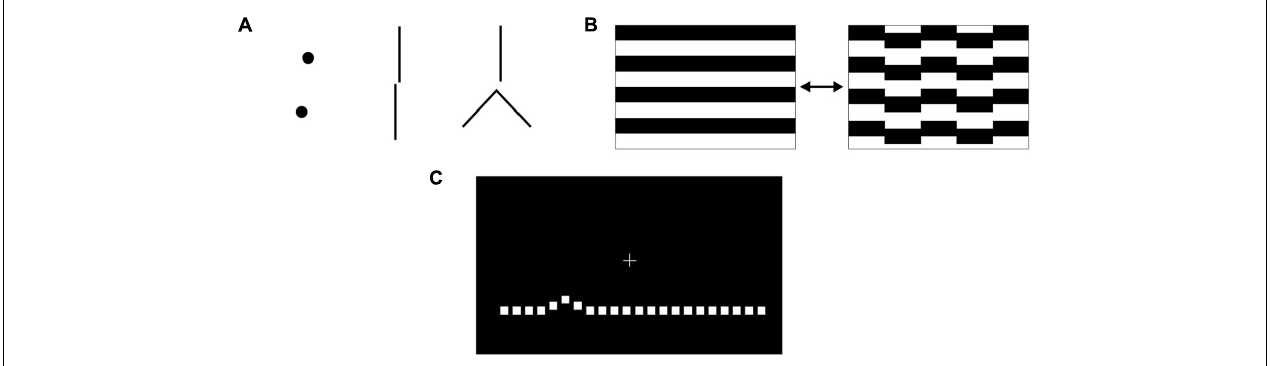
FIGURE 2 | (A) Vernier stimuli can consist of pairs of discrete dot-like shapes, lines or other juxtaposed elements where an offset occurs in a direction perpendicular to a line joining the features of interest. (B) When measuring vernier acuity with steady state visual evoked potentials, animations that transition between aligned and misaligned stimuli are used. (C) Preferential hyperacuity perimetry requires the subject to identify misaligned dots on a computer